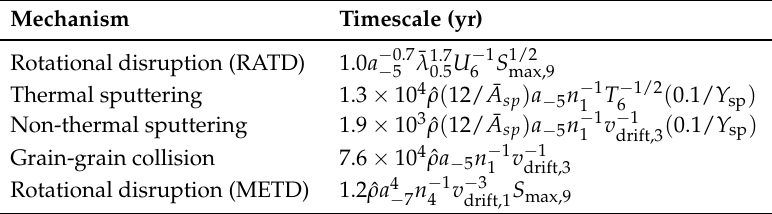
Table 1. Characteristic timescales of dust destruction by different